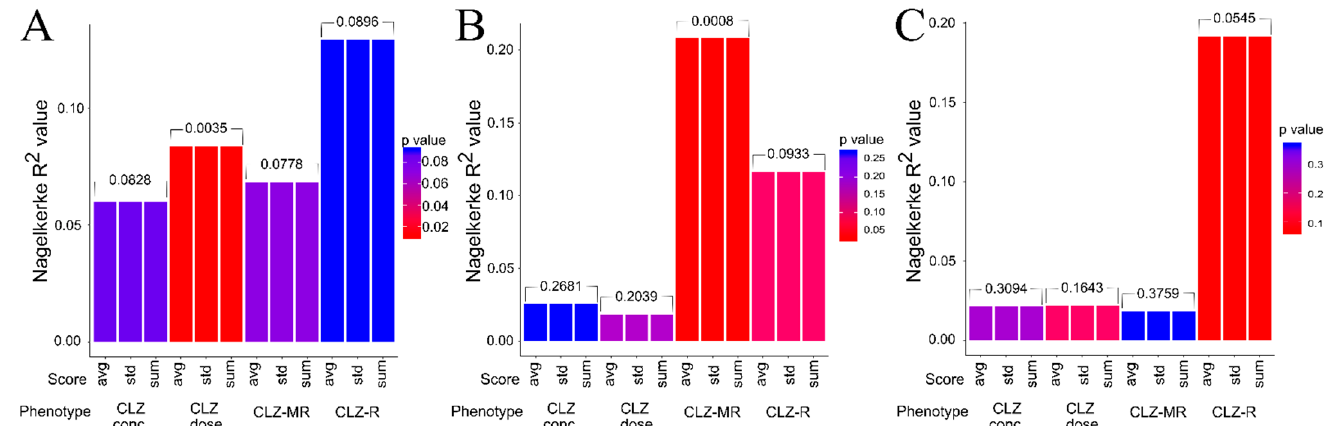
Figure 1. Results of polygenic risk score (PRS) analysis for major depressive disorder ( A ), bipolar disorder ( B ), and schizophrenia ( C ) and their associations with clozapine-associated phenotypes. The X -axis contains the clozapine-associated phenotypes and the Y -axis shows the proportion of variance explained by the PRS that was calculated by Nagelkerke’s pseudo-R 2 value. The colors of the bars are in accordance with the associated p -values (e.g., the redder the bar, the more significant the p -value). Abbreviations: CLZ, clozapine; conc, concentration; MR, metabolic ratio; R, response; avg, average; std, standard.